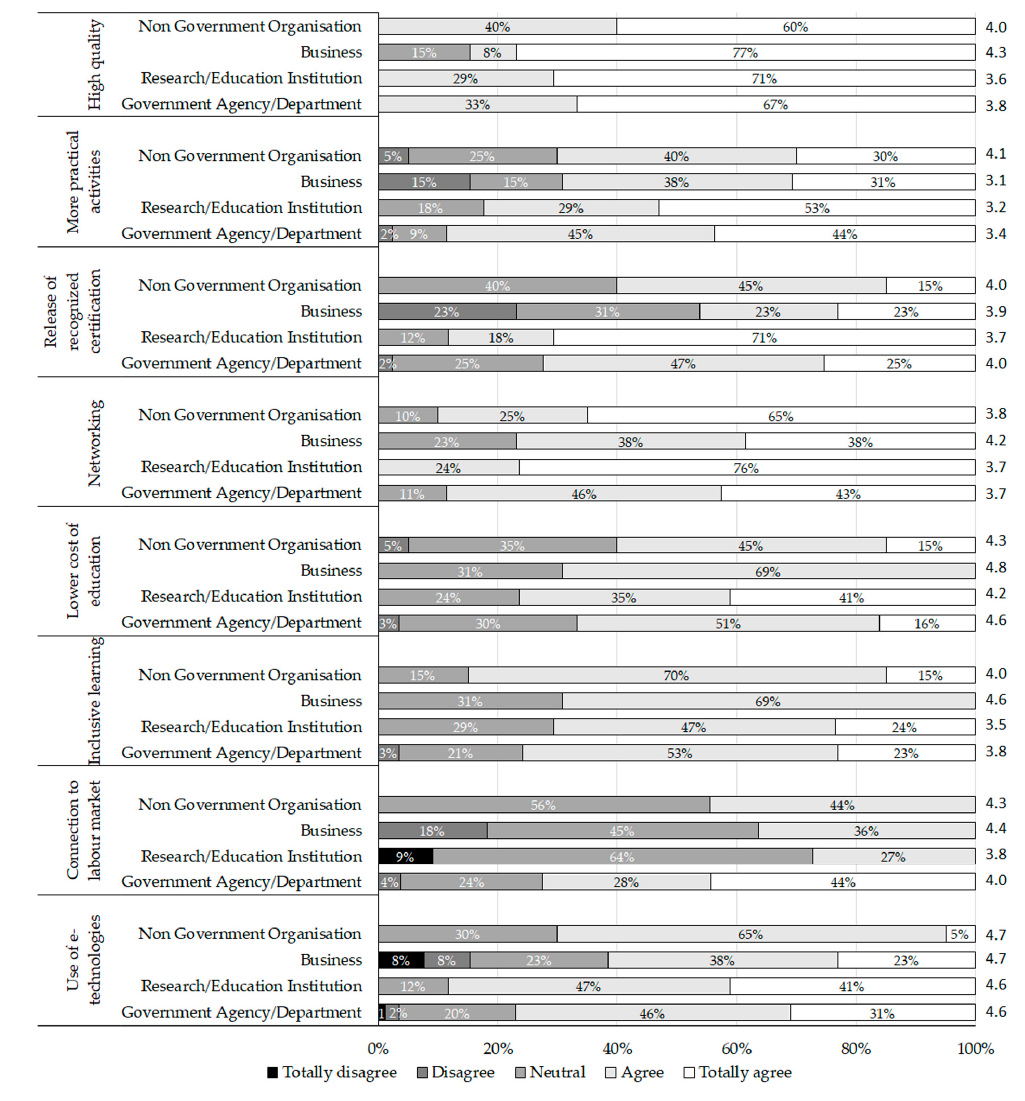
Figure 8. Level of agreement on suggested recommendations for improved training provision. The percentages of selections for each level of agreement are reported in the bars. Statistical differences between percentages have been identified by the Fisher exact test. Mean values of agreement have been calculated by assigning 5 to Totally agree, 4 to Agree, 3 to Neutral, 2 to Disagree, and 1 to Totally disagree. Mean values are shown on the right side of the bars. Statistical differences between mean values of different categories (in cases indicated by small letters next to the mean values) have been identified by the ANOVA test, followed by the LSD test at p < 0.05 ( n = 137).